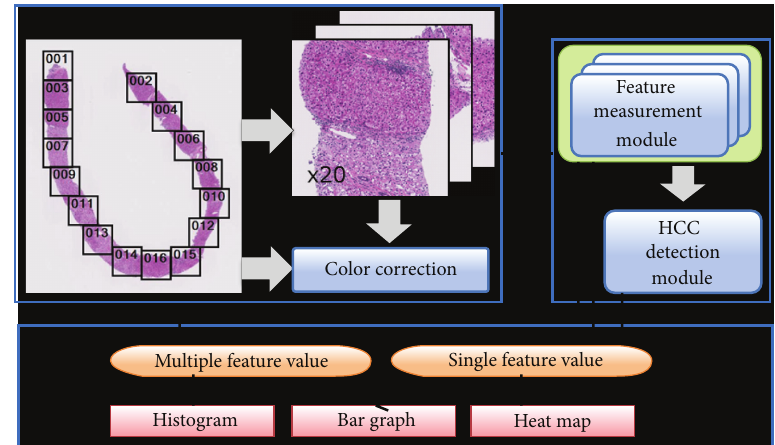
Figure 1: Schematic diagram of prototype system.